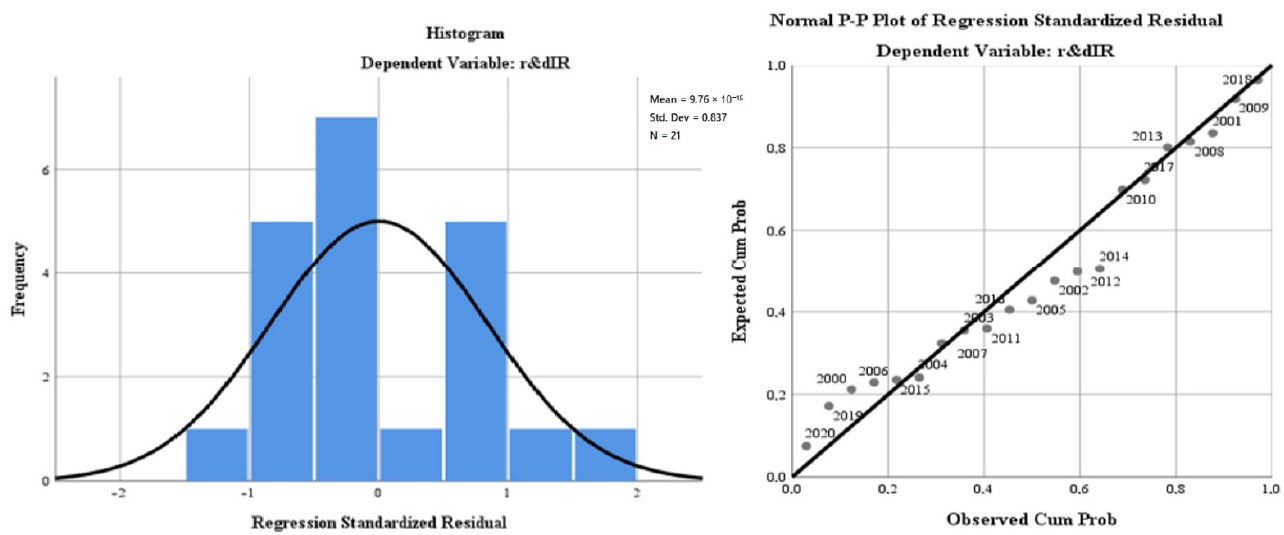
Figure 6. Regression analysis for Ireland during 2000–2020. Source: Data operated under IBM-SPSS 25 (IBM, Armonk, NY, USA).